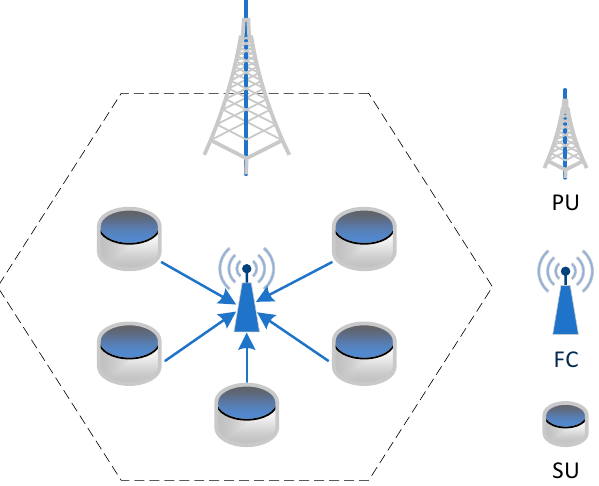
Figure 1. Cognitive radio wireless sensor network (CRWSN) system model.